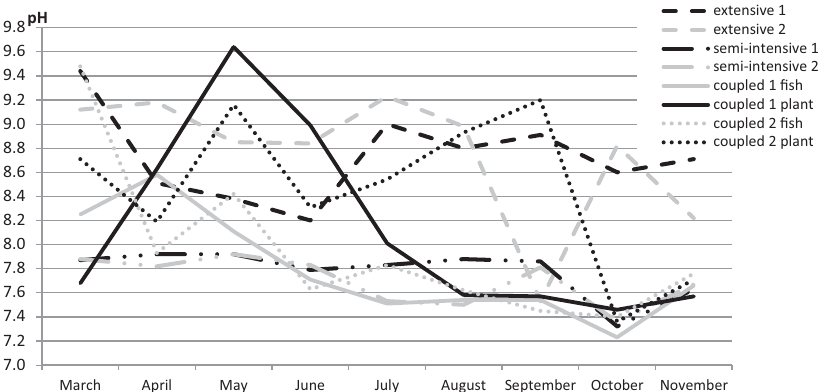
Fig. 3. Water pH dynamics during the rearing period in two replicates of carp polyculture ponds: extensive (without formulated feed), semi- intensive (with feed and double fi sh density) and coupled (semi-intensive ( fi sh) þ planted lagoon (plant)).